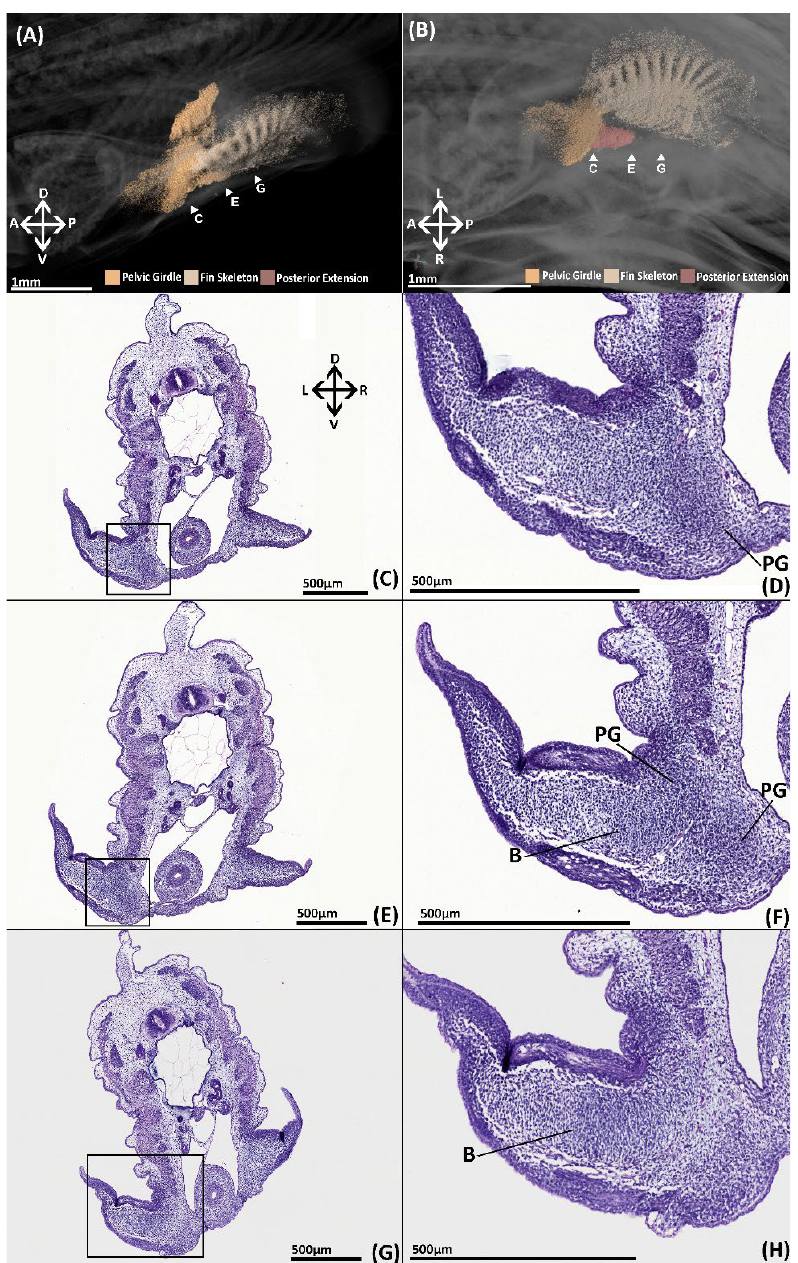
Figure 4. NanoCT models ( A , B ) and transverse paraffin sections ( C – H ) of a male stage 30 elephant shark ( Callorhinchus milii ) embryos. Sections are stained with haematoxylin, eosin and alcian blue and presented in an anteroposterior order. ( A ) 3D models of the pelvic skeleton of C. milli from a distal lateral view showing the span of the pelvic girdle; ( B ) same models from a ventral view showing the rays forming the basipterygium and the articulation of the fin skeleton on the pelvic girdle; ( C ) trunk section showing early mesenchymal condensation of the pelvic girdle; ( D ) close up of C within the black box; ( E ) trunk section showing the early mesenchymal pelvic and basipterygium; ( F ) close up of E within the black box; ( G ) trunk section showing extent of the mesenchymal basipterygium within the pelvic fin; ( H ) close up of G within the black box. B - basipterygium PG-pelvic girdle. Anatomical orientation of models indicated by A-anterior D-dorsal P-posterior R-right L-left V-ventral.